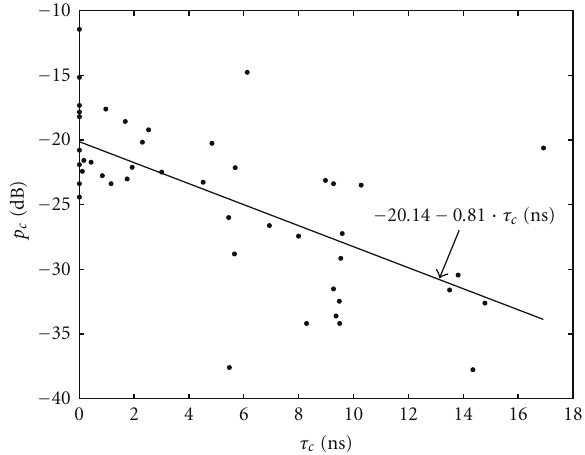
Figure 8: Scatter plot of p c versus τ c and fitted exponential law